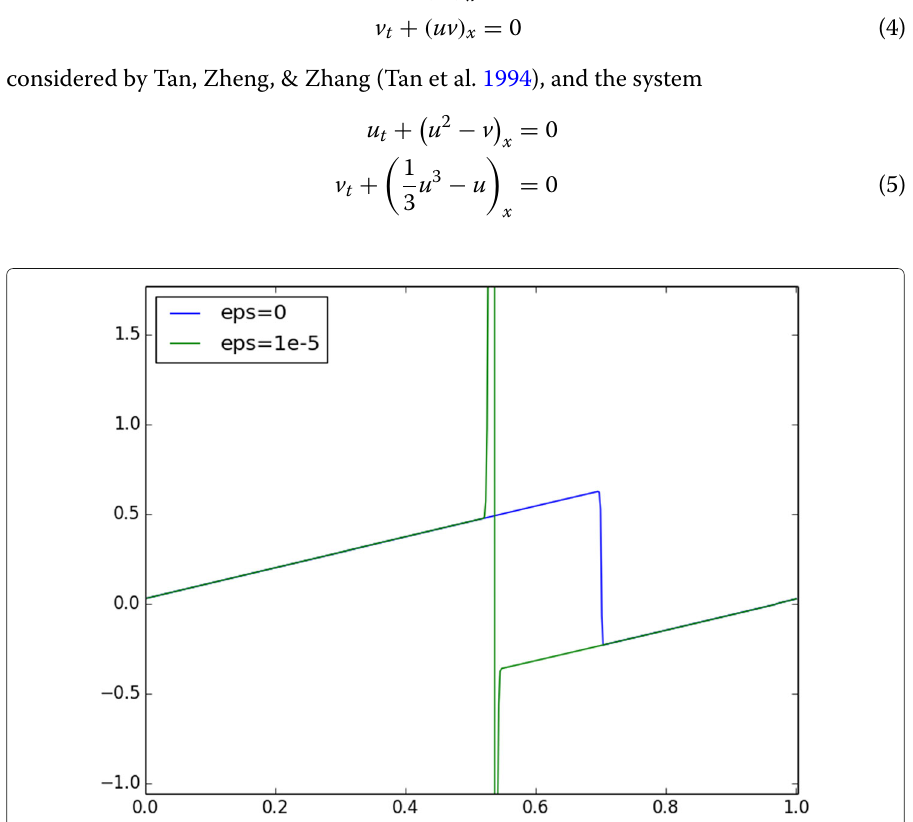
Fig. 2 Irregularized Hopf equation. (Color online) Simulation of the irregularized Hopf Eq. (17) for two values of (cid:6) , at time t = 1 (simulated with a conservative upwind differencing). Note that the singularity has both a positive and negative peak. Only the sum contributes to the delta shock; the difference can be described as a derivative of a δ